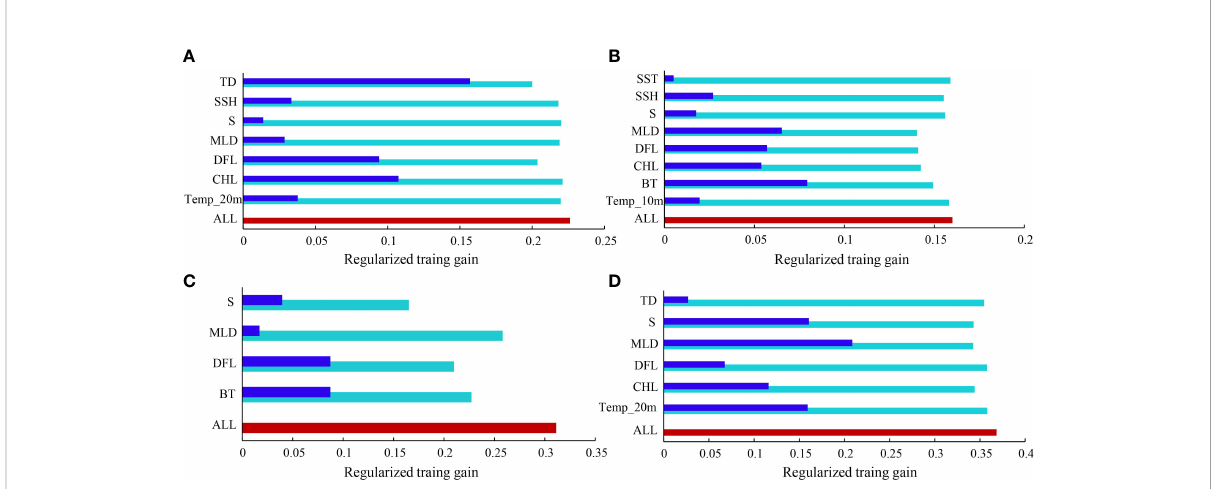
FIGURE 3 Jackknife test of environmental variable importance for training data in the current scenario model of Trichiurus japonicus distribution in the Beibu Gulf in different seasons: (A) spring; (B) summer; (C) autumn; (D) winter. Colors of the bars represent the contribution when the model is executed only with the variable, without the variable, or with all variables.